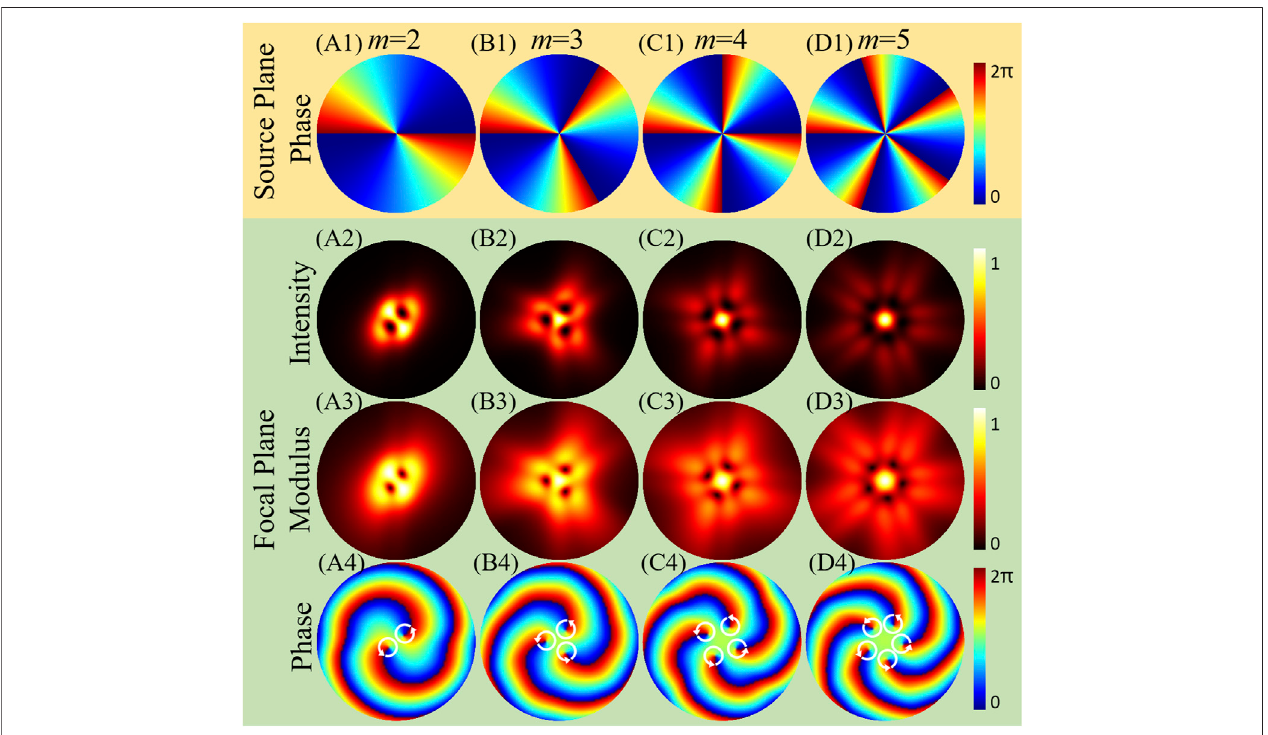
FIGURE 4 | Numerical simulation initial phases, intensities, and CSD distributions of the PC-PEPV with high spatial coherence ( σ (cid:1) 20 mm) and power order n (cid:1) 2. (A1 – D1) aretheinitialphasesonthesourceplane, (A2 – D2) aretheintensitypatterns, (A3 – D3) arethemodulusoftheCSDfunction,and (A4 – D4) arethephasepatterns oftheCSDfunction.Allresultsarecalculatedonthefocalplane,excepttheinitialphase.Whitecirculararrowsrepresenttheanticlockwisedirectionofthephasewinding which indicates the positive TC.